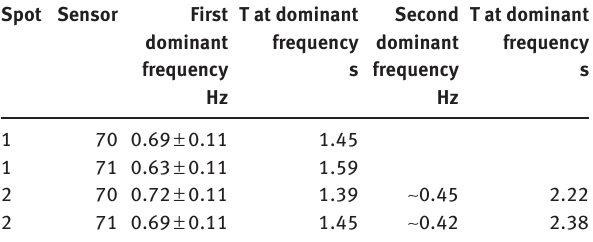
Table 3: HVSR results. Spot Sensor